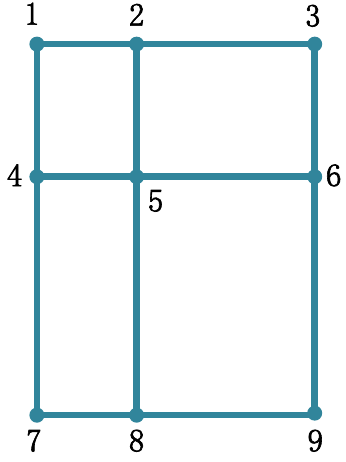
Figure 3. Schematic Diagram of Indoor Network.